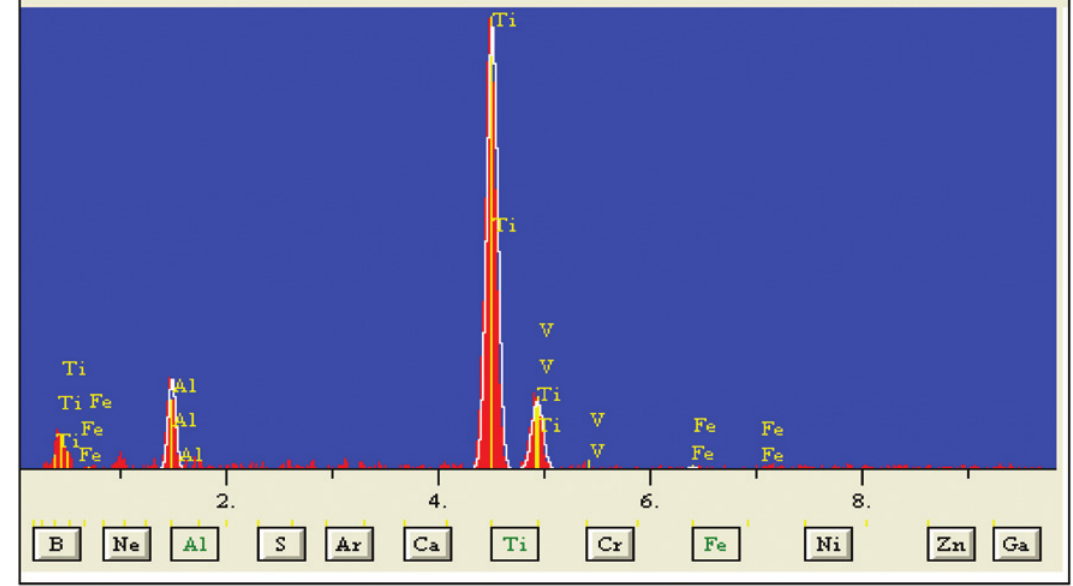
Figure 1 Ti-6Al-4V: EDS analysis.